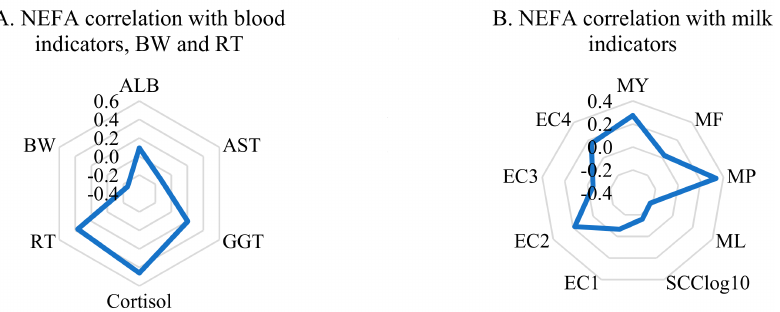
Figure 2. Correlations of NEFA levels with ( A ) blood indicators and ( B ) biomarkers from the automated health-monitoring system.